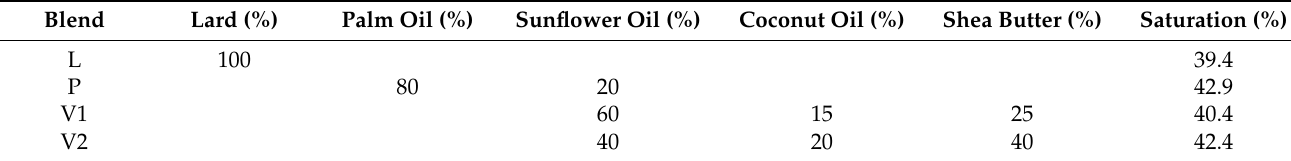
Table 1. Compositions of fat blends used to prepare different “ sfogliatella riccia napoletana ” SRN. Blend Lard (%) Palm Oil (%) Sunflower Oil (%) Coconut Oil (%) Shea Butter (%) L 100